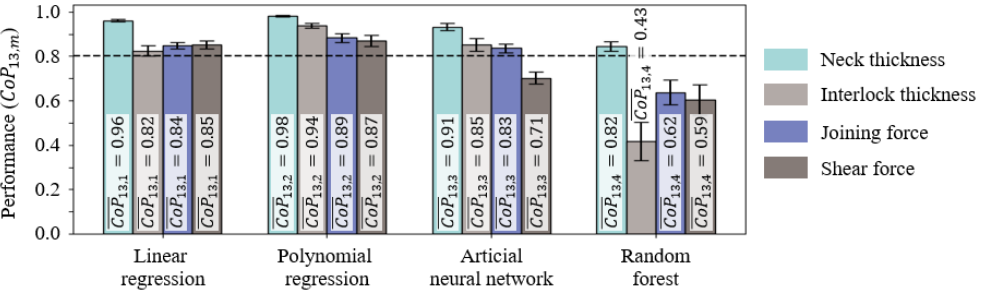
Figure 5. Performance of machine learning algorithms for the estimation of individual clinch joint